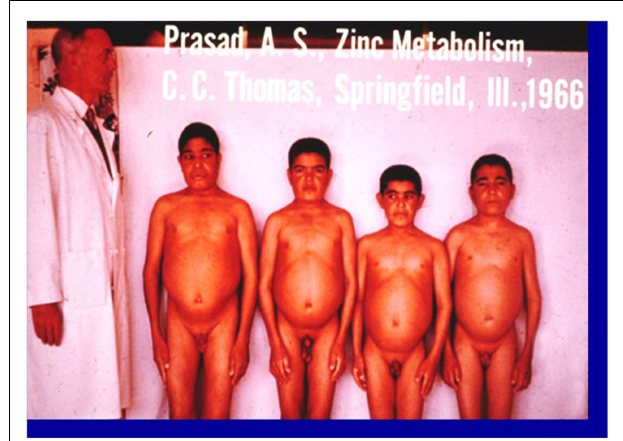
FIGURE 1 |A picture of four dwarfs from Iran . From left to right (i) Age 21years, height 4ft, 11 (1/2 (cid:48)(cid:48) ); (ii) age 18years, height 4ft 9 (cid:48)(cid:48) ; (iii) age 18years, height 4ft 7 (cid:48)(cid:48) ; (iv) age 21years, height 4ft 7 (cid:48)(cid:48) Staff physician at left is 6ft in height (1).